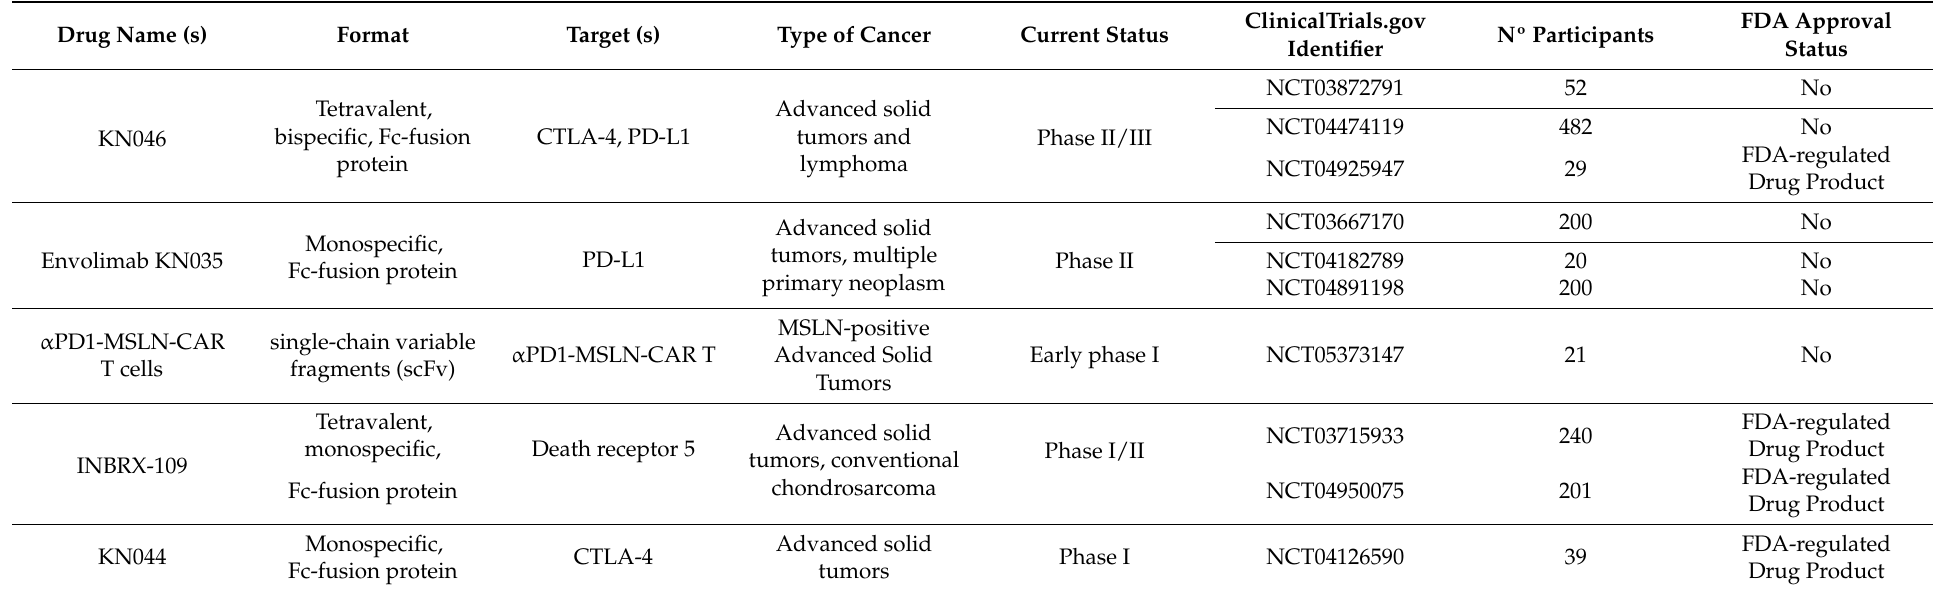
Table 1. Summary of the most commonly used nanobodies for solid tumors, ongoing in clinical